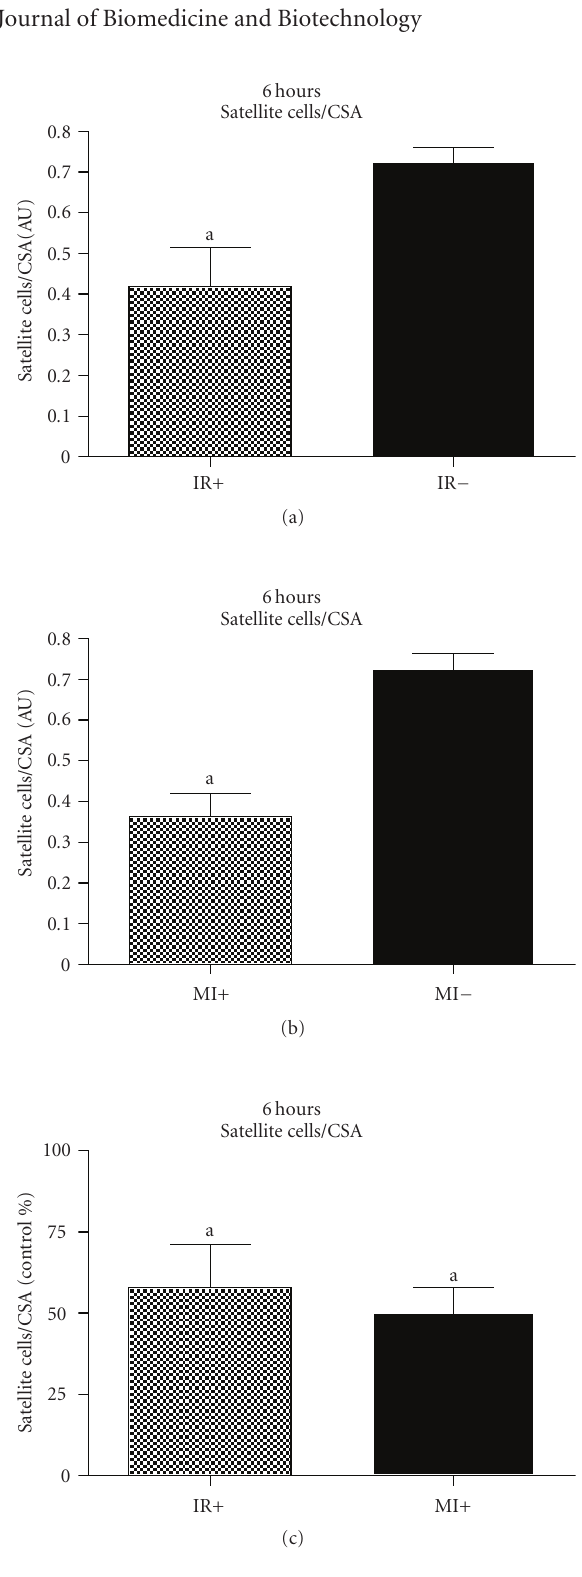
Figure 7: Number of Myf5 cells 3 hours after ischemia-reperfusion injury and myotoxin injury. Values are means ± SEM. Number of data per group is 4–6. IR+: ischaemic/reperfused muscles, IR − : control muscles of ischaemic/reperfused muscles, M+: myotoxin- treated muscles, M − : control muscles of myotoxin-treated muscles. (a) significantly di ff erent from control ( P < .